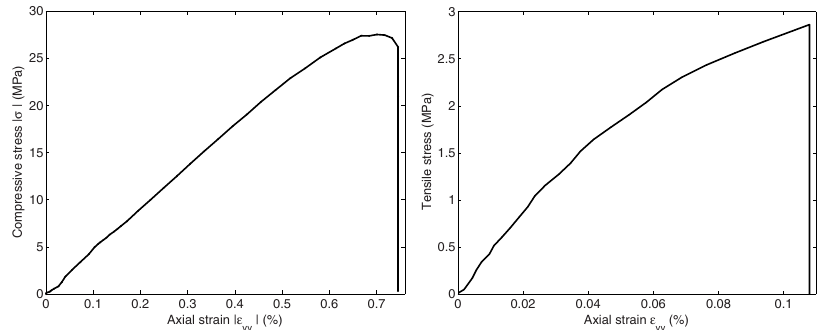
axial strain (Figure 4). On the contrary, the uni-DIC approach leads directly to a homogeneous strain value: the axial strain at failure is (cid:0) 0.74 (cid:6) 0.03 %. The stress-strain curve (Figure 5) shows that the mechanical behaviour is elastic linear until a strain of (cid:0) 0.50 (cid:6) 0.05 % is reached. The secant modulus remains almost equal to 4.6 GPa until this strain limit. Strains have been quanti(cid:12)ed according to the beam-DIC approach during the four-point bending test in section 4.1: the value of (cid:0) 0.15 % was reached in the compressive part of the beam just before the catastrophic failure. It means that the mechanical behaviour for the compressive part of the bent beam can be considered as elastic linear with a Young modulus of 4.6 GPa. - For the tensile Test, the measured maximum stress is equal to 3.0 (cid:6) 0.3 MPa for an axial strain of +0.11 (cid:6) 0.05 % using the uni-DIC approach. The stress-strain curve is not linear and the secant modulus descreases progressively from 4.7 to 2.7 GPa. The initial modulus is almost equal to the one measured in compression. This damageable behaviour is linked to the progressive propagation of the grain boundary micro cracks of the aluminium titanate. The maximum strain is +0.11 % in the tensile test whereas values of +0.26 % have been measured during the four-point bending test. Smaller strains in tension than in bending tests have already been observed in literature [4,11]. Beyond the Weibull modulus, it may come from a stress concentration due to inaccurate boundary conditions. An other reason may be a structural e(cid:11)ect: the transition from stability to instability depends on the whole stress (cid:12)eld of the considered structure [11].